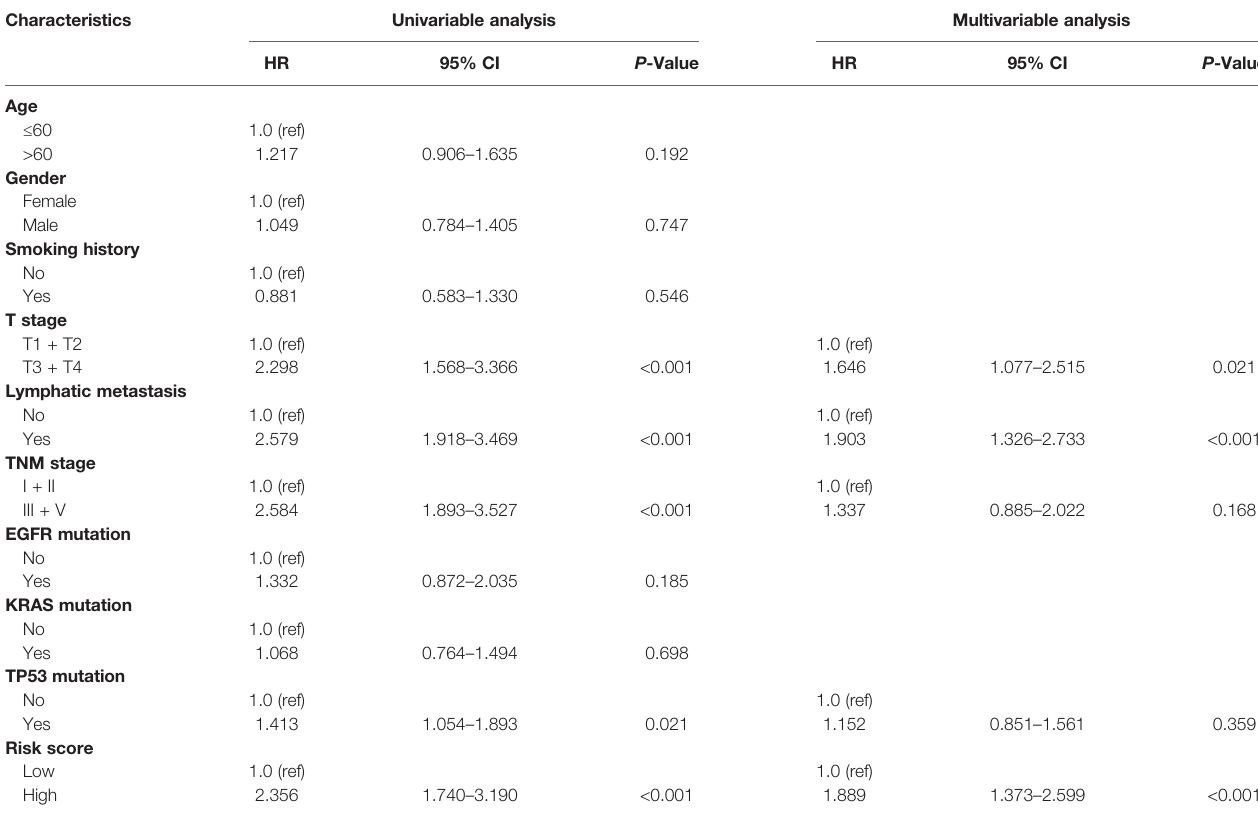
TABLE 2 | Univariable and multivariable Cox regression analysis of the NK cell marker genes signature in TCGA LUAD cohort.